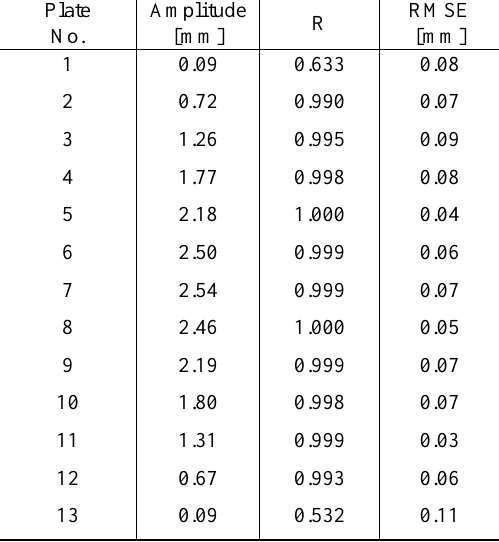
Table 8. Estimated amplitude, Pearson’s coefficient, and root Table 10. Estimated amplitude, Pearson’s coefficient, and root mean squared error for all plates using medium